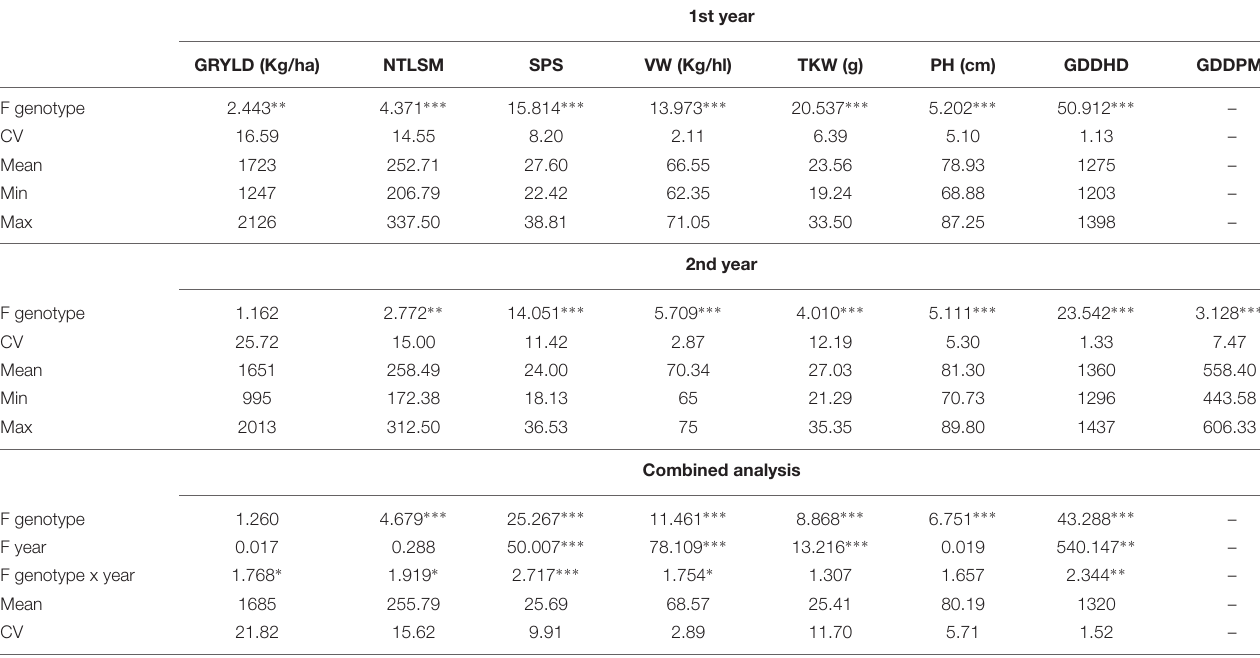
TABLE 2 | Analysis of Variance F -values for genotypes, Coefficients of Variation (CV), means, minimum (Min) and maximum (Max) values of grain yield (GRYLD), number of tillers per m 2 (NTLSM), seeds per spike (SPS), volume weight (VW), thousand kernel weight (TKW), plant height (PH), growing degree days to heading (GDDHD) and growing degree days from heading to physiological maturity